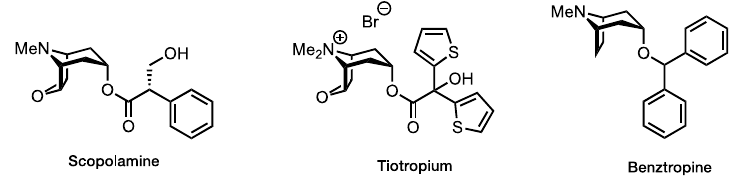
Figure 1. Examples of clinically approved pan-antimuscarinic drugs.